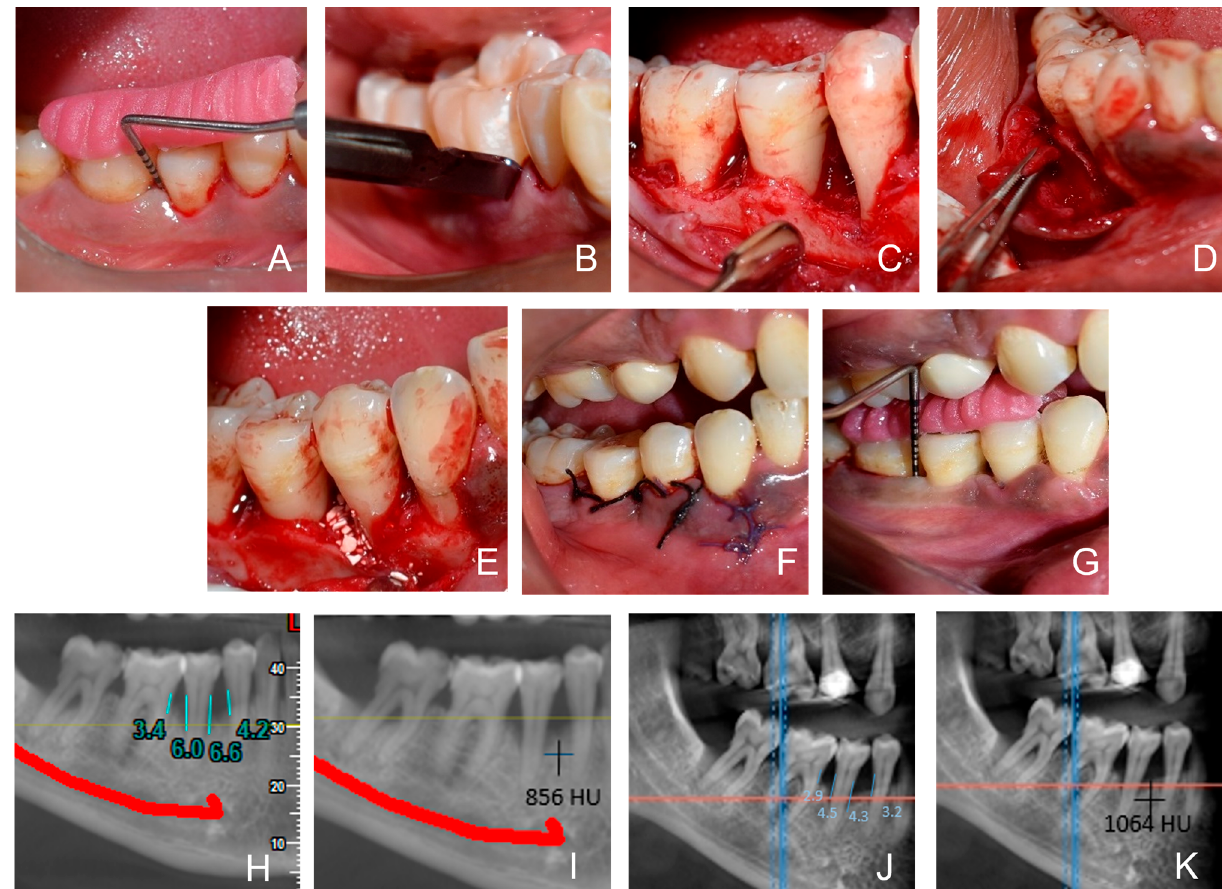
Figure 2. showing surgical photographs of study group A ( A )–pre op measurements, ( B )–incision, ( C )–reflection and debridement, ( D )–separation of periosteum from mucoperiosteal flap, ( E )–placement of eggshell graft into the defect, ( F )–suturin, ( G )–6 month follow up, ( H )–pre op CBCT showing defect characteristics, ( I )–pre op CBCT showing density, ( J )–post op CBCT showing bone fill, ( K )–post op CBCT showing density change.